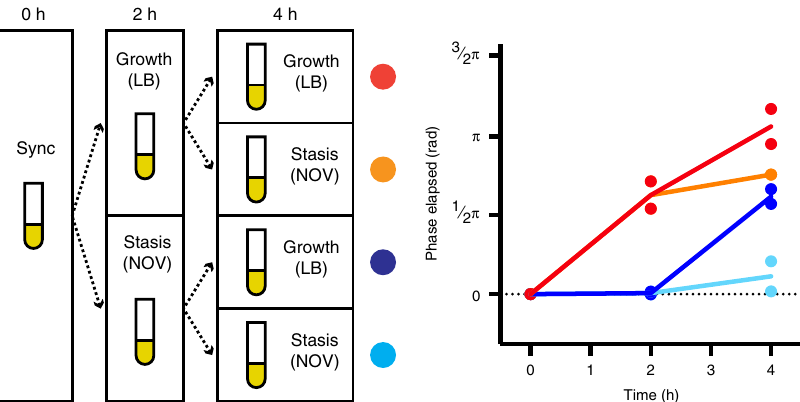
Fig. 3 RINGS is unaffected by variable bacterial growth. To test the ability for RINGS analysis to track and integrate growth under variable conditions, IPTG- synchronized PAS715 was back-diluted and grown in liquid culture in the presence or absence of bacteriostatic concentrations of novobiocin. Following 2 h of growth, each culture was washed and split again to be grown under the presence or absence of novobiocin, generating four unique combinations of expected growth and non-growth. The phase of populations sampled at 2 and 4 h were consistent with the expected growth phenotype. In particular, the equivalence of the two populations exposed to one period with and one period without novobiocin, irrespective of order, demonstrates the ability to measure absolute growth during periods of variable growth rate. Mean phase ( θ 0 ) from two independent biological replicates is shown. Numbers of colonies analyzed per timepoint are as follows: Rep 1/2 – 0 h: 13/20. 2 h LB: 57/26. 2 h novo: 101/69. 4 h LB-LB: 14/60. 4 h LB-novo: 23/42. 4 h novo-LB: